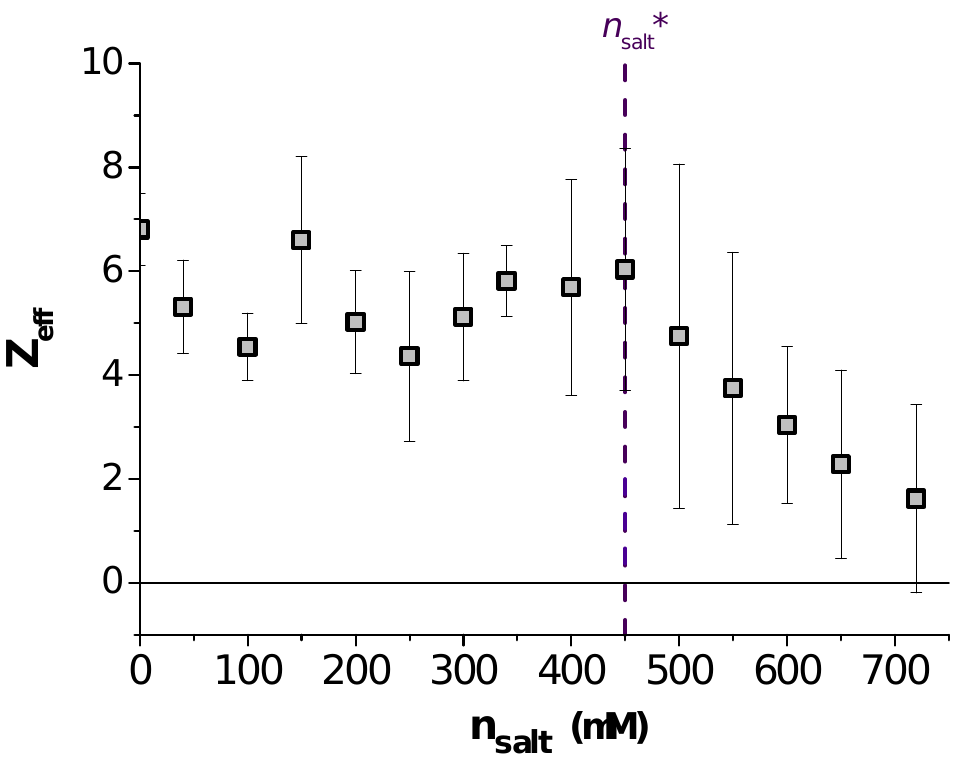
= Z (cid:96) / a (bottom) from eff B . A critical electrolyte salt